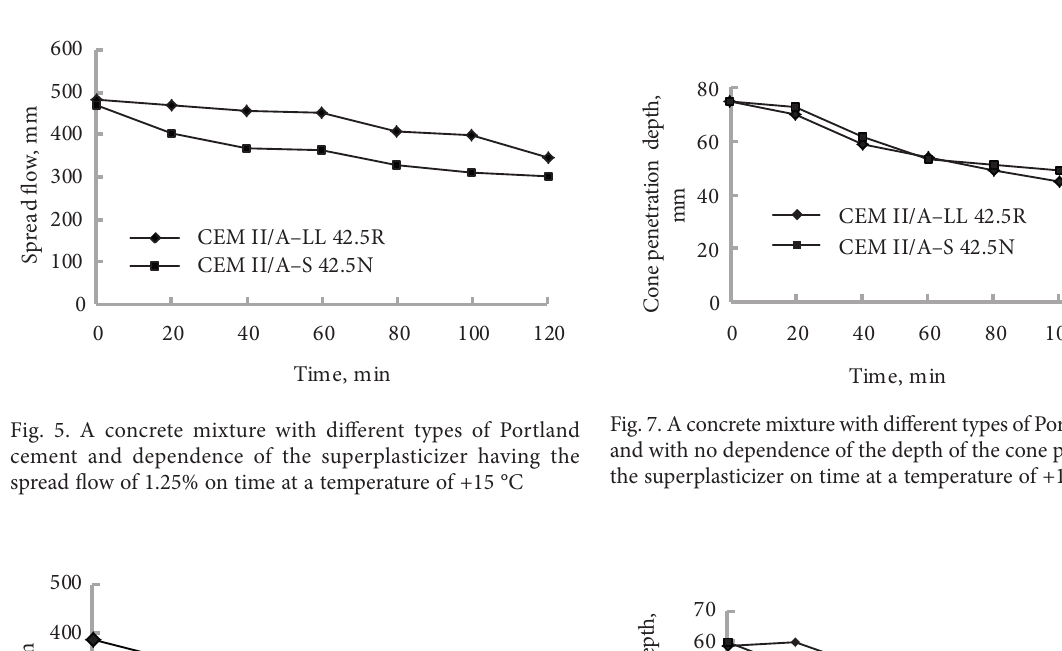
Fig. 8. A concrete mixture with different types of Portland cement and dependence of the depth of the cone penetration of the superplasticizer on time at a temperature of +15